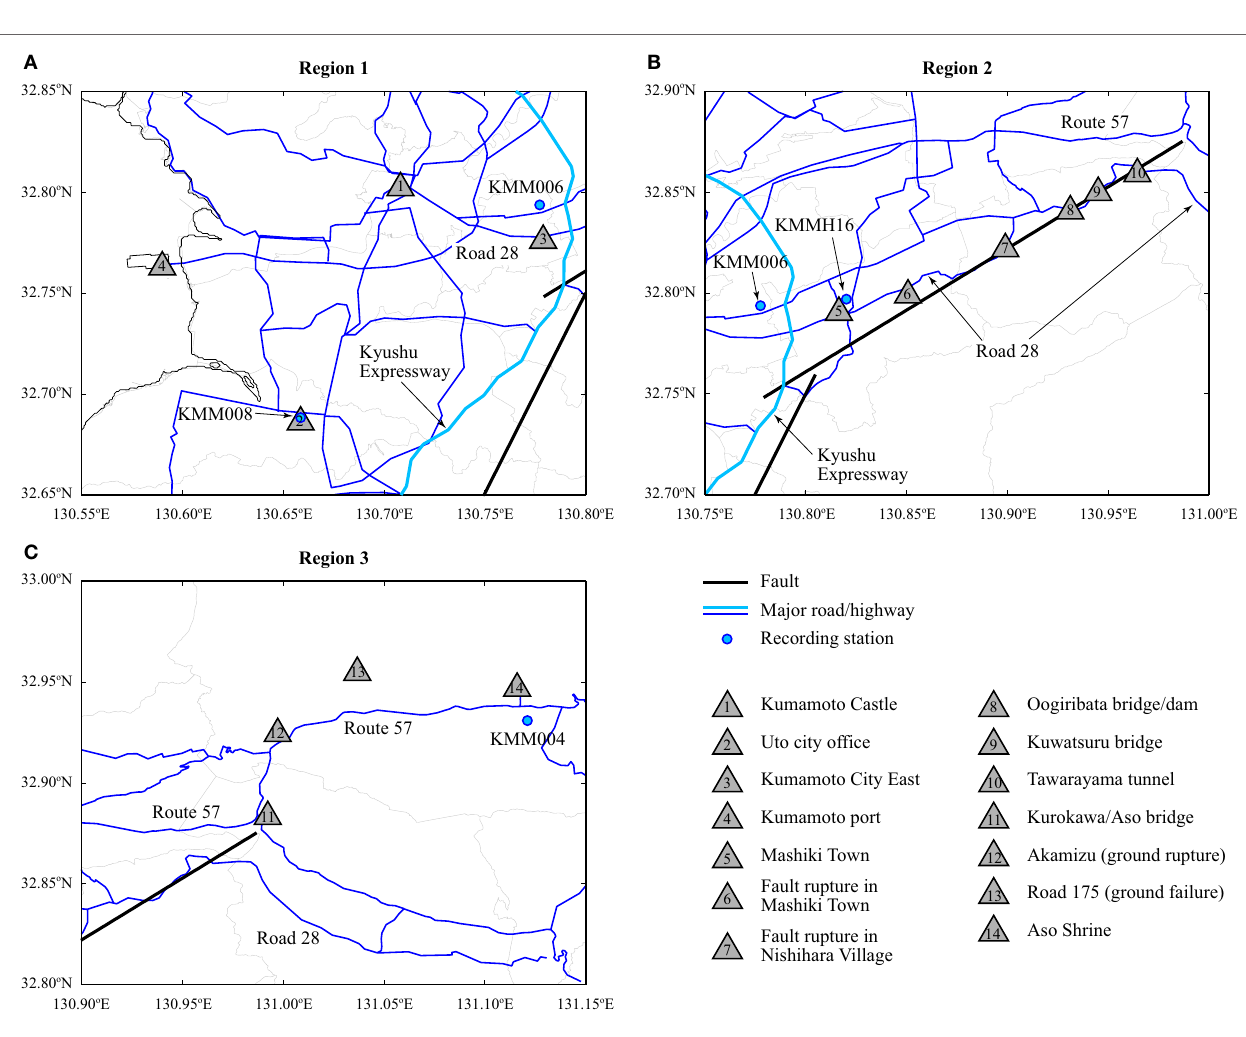
FigUre 11 | locations of earthquake damage surveys: (a) region 1, (B) region 2, and (c) region 3